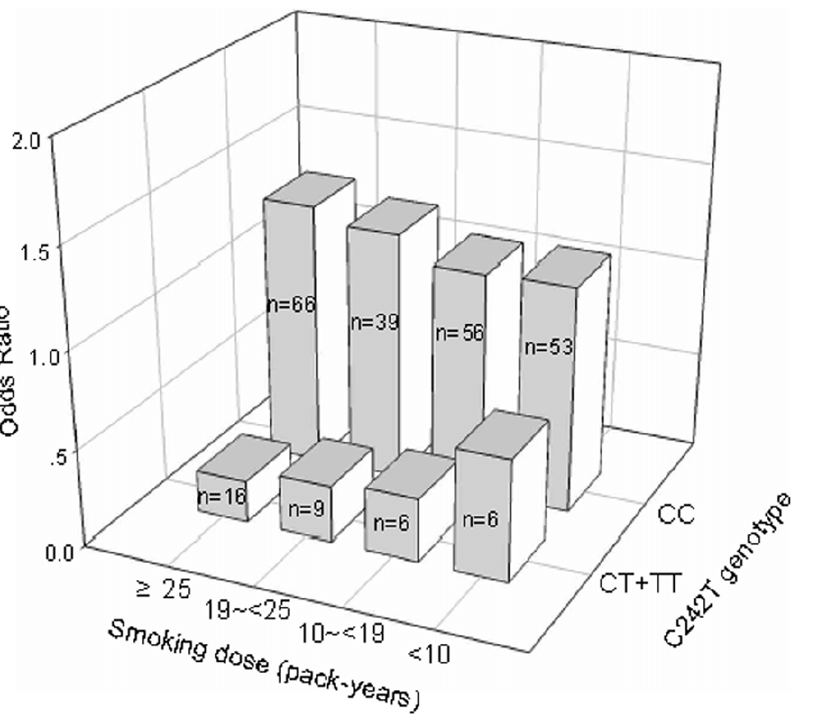
Figure 2. Difference of prevalence of metabolic syndrome between C242T genotypes in different smoking dose groups. The odds of prevalence of metabolic syndrome in genotypic group is expressed relative to the participants in each smoking dose group, and adjusted for the same covariates as in the Figure 1.